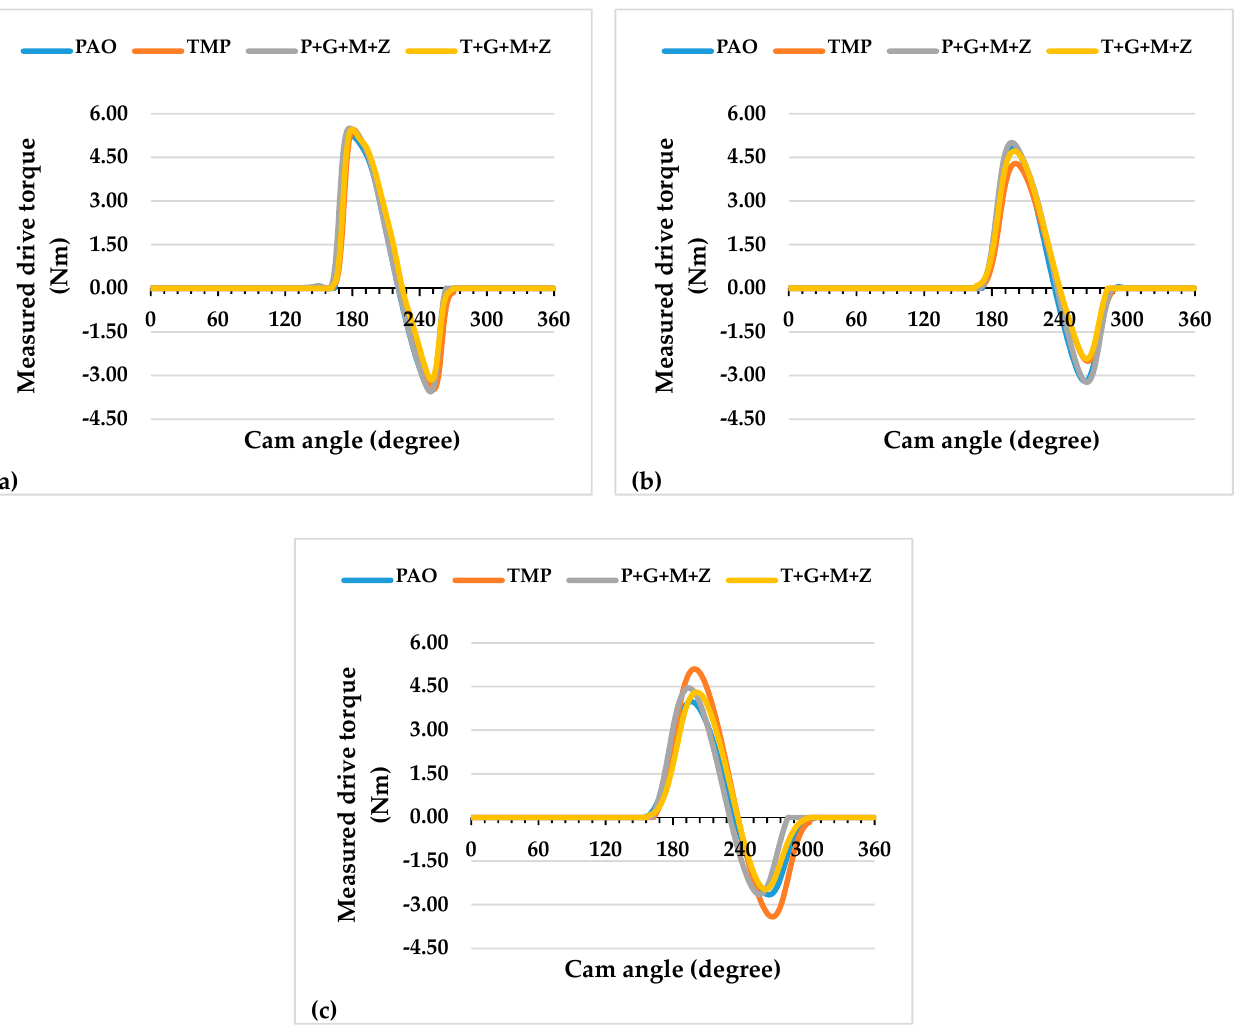
Figure 12. Instantaneous exhaust camshaft drive torque with a-C:H:W-coated tappets and a-C:H:W-coated camlobes at a lubricant temperature of 40 °C and camshaft speeds of ( a ) 400 RPM, ( b ) 800 RPM, and ( c ) 1200 RPM.